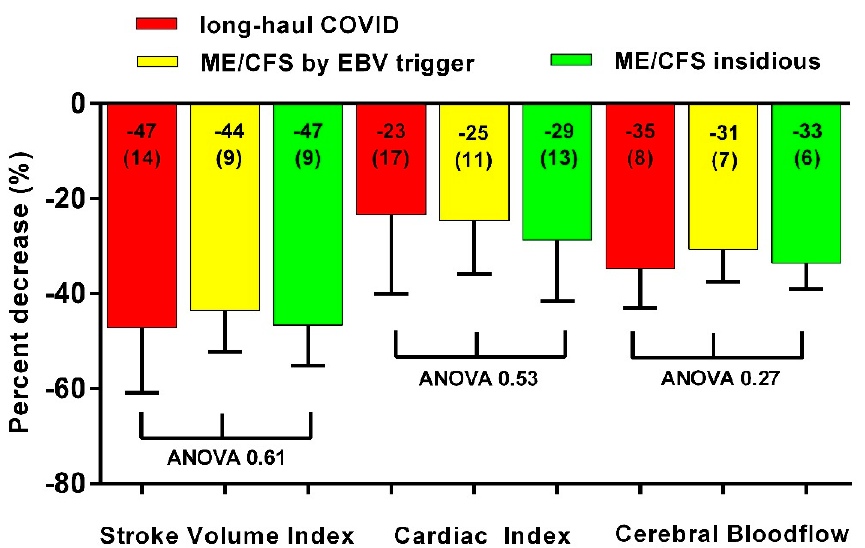
Figure 1. Decrease in stroke volume index, cardiac index and cerebral blood flow in long-haul COVID cases (red bars), in ME/CFS controls triggered by EBV (yellow bars) and in ME/CFS controls with an insidious onset (green bars). ME/CFS: myalgic encephalomyelitis/chronic fatigue syndrome; EBV: Ebstein Barr Virus.